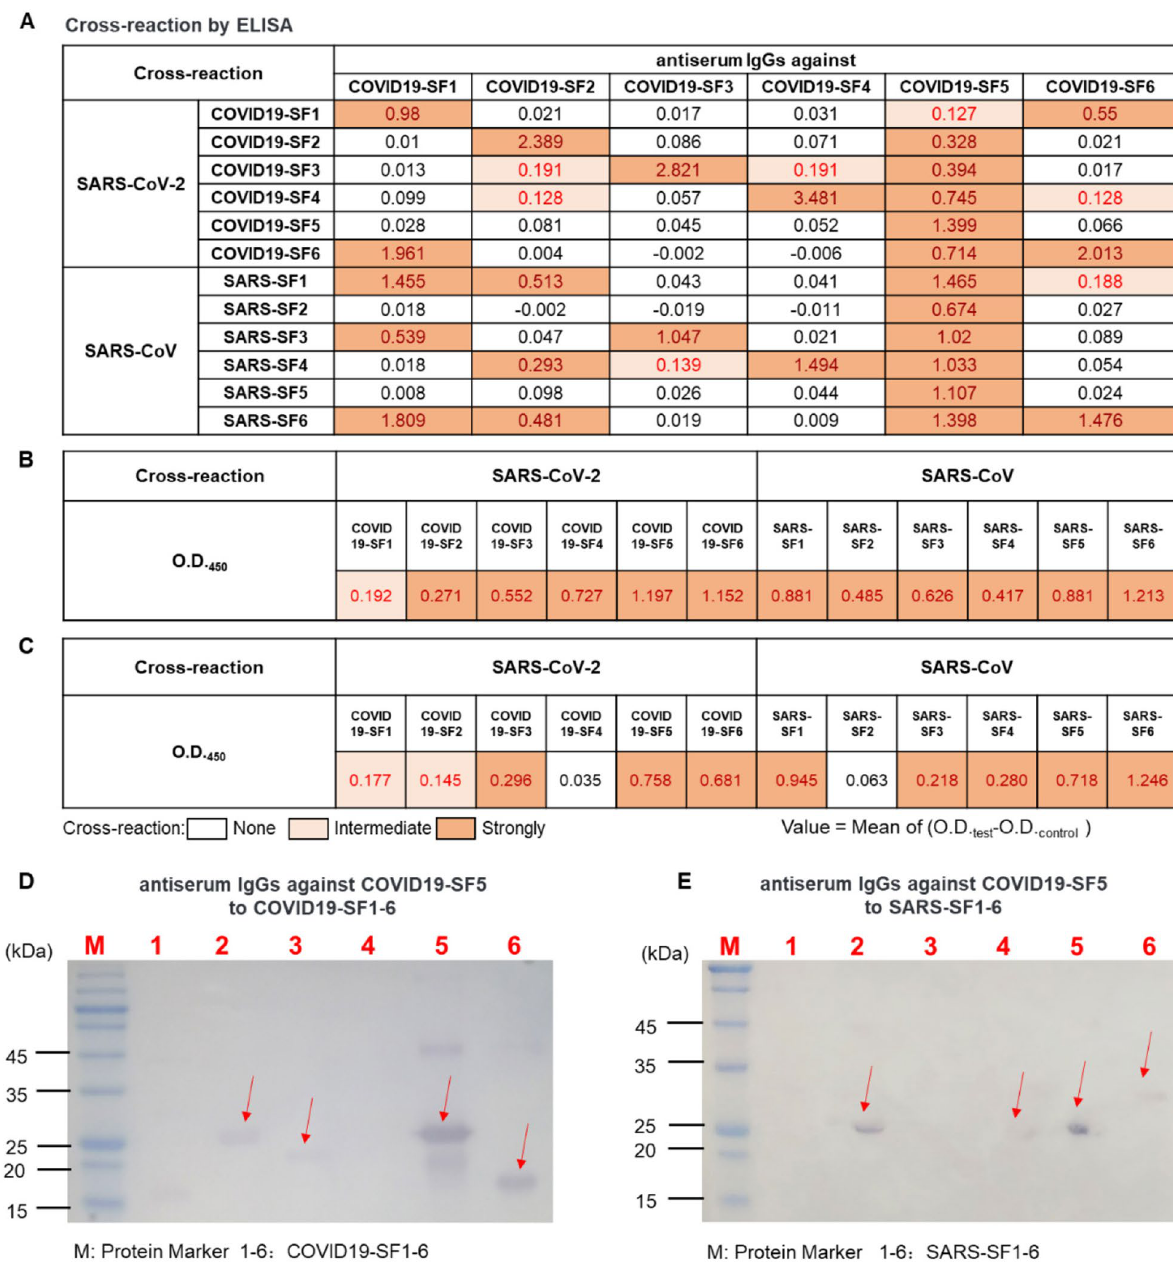
Figure 4. Cross reaction of the IgGs against COVID19-SF5 to 12 fragments. ( A ) ELISA testing of the IgGs (0.05 μg/mL) against 6 protein fragments of SARS-CoV-2 with the 12 protein fragments (10 pmol/well) of SARS-CoV-2 and SARS-CoV. ( B and C ) ELISA testing of the IgGs (0.05 μg/mL) against COVID19-SF5 with the 12 protein fragments (10 pmol/well) of SARS-CoV-2 and SARS-CoV. Antiserum was obtained after 3 ( B ) or 6 ( C ) months from the first immunization. Deep pink indicates a strong reaction (O.D. test − O.D. control > 0.2), light pink indicates an intermediate reaction (0.2 > O.D. test − O.D. control > 0.1), and white indicates no reaction (O.D. test − O.D. control < 0.1). Mean values of 3 biological replicates are shown. ( D and E ) Immunoblotting of anti- serum (0.2 μg/mL) against COVID19-SF5 with 12 fragments (1 μg) of SARS-CoV-2 ( D ) and SARS-CoV ( E were used to characterize the neutralization ability of pseudovirus infection in 96-well plates. As shown in Fig. 7A, the 6 recombinant fragment proteins inhibited SARS-CoV-2 pseudovirus infection with infection rate from about 20–50%. Among them, COVID19-SF5 displayed the strongest inhibition of pseudovirus infection to the cells. In addition, the 6 anti-sera also showed some neutralization effect on SARS-CoV-2 pseudovirus infec- tion of the cells (Fig. 7B). Collectively, our data indicate that both proteins and specific IgGs were able to neutralize pseudovirus, thus preventing the infection of host cells although the effect varied between IgGs and fragments.